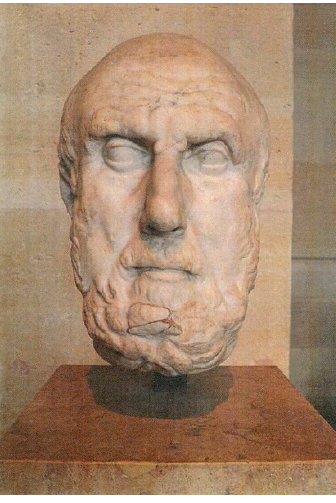
Figure 2. Portrait of Stoic philosopher Chrysippus [Source: https://commons.wikimedia.org/wiki/File:Portrait_of_the_Stoic_philosopher_Chrysippus,_2nd_cent ury_AD,_Louvre_Museum_(7462805964).jpg].